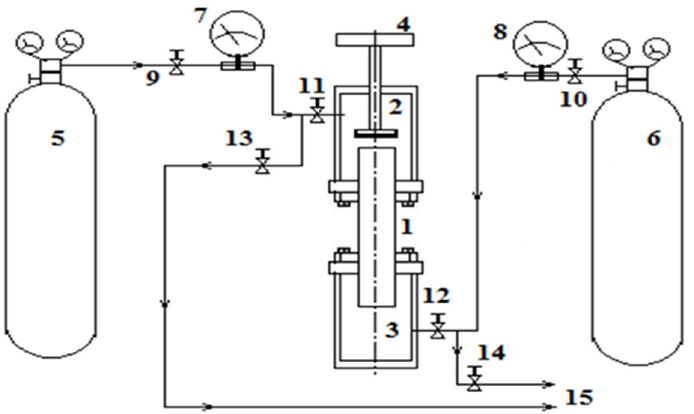
Figure 1. Schematic diagram of the experimental stand [15].